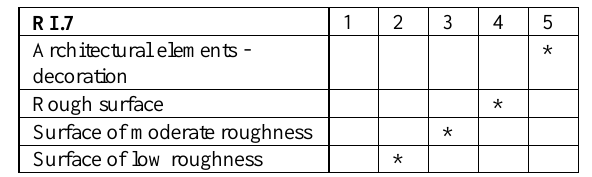
Table 12. Type of Architectural